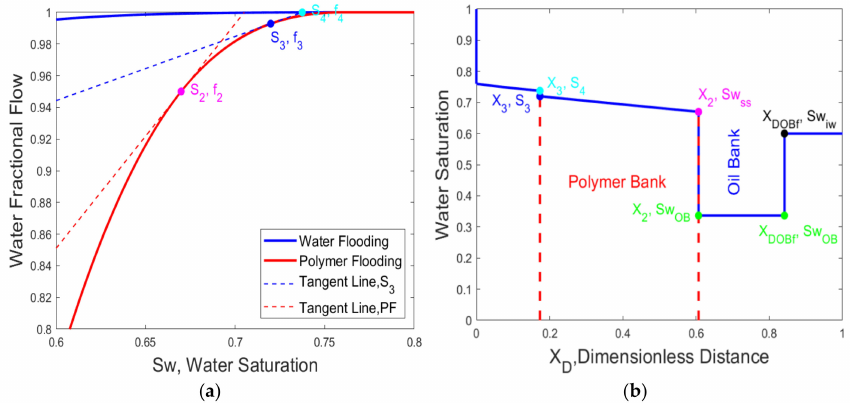
Figure 21. ( a ) Determination of the shock front during polymer slug injection; ( b ) Profile of water saturation and oil bank at t d , slug = 0.30 PV, t d , total = 0.43